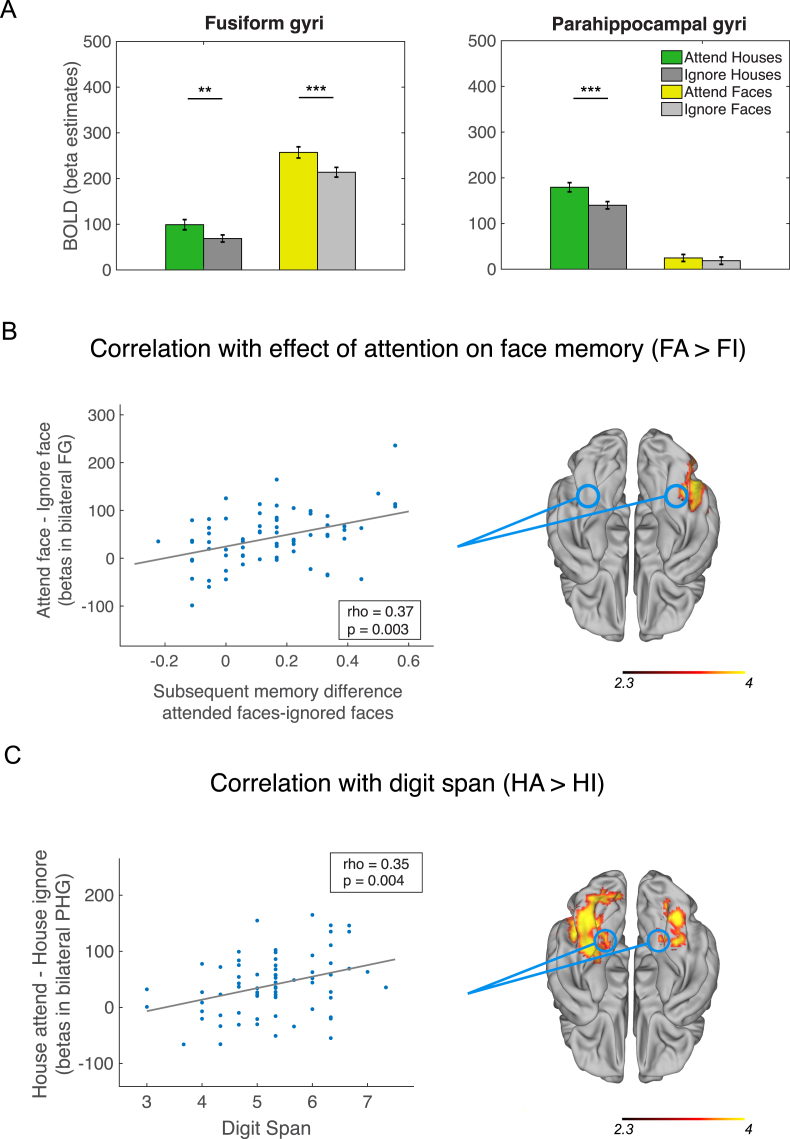
Top-down attentional modulation in category-sensitive visual cortex during selective WM and correlations with behavior. (A) Bar plots showing attention-related modulation of category-sensitive visual cortex (ROI analyses). Left: BOLD activity in bilateral fusiform gyri (FG) was modulated by stimulus category, with greater activity for faces than houses, but attention-related modulation was similar for faces and houses. Bilateral FG showed greater activity in the attend-face (FA; yellow) versus the ignore-face (FI; light grey) conditions, as well as in the attend-house (HA; green) compared to the ignore-house (HI; grey) conditions. Right: BOLD activity in bilateral parahippocampal gyri (PHG) was modulated by stimulus category, with greater activity for houses than faces, and displayed strongly selective attention-related modulation for WM encoding of houses. Bilateral PHG showed greater activity in the attend-house (HA; green) compared to the ignore-house (HI; grey) conditions, but not for attend-face (FA; yellow) versus the ignore-face (FI; light grey) conditions. ***p < 7.89e-08; **p = 0.0003. Beta estimates are in arbitrary units. Error bars represent standard error of the mean. (B–C) The degree of attention-related modulation was positively correlated with the effect of attention on subsequent memory and with digit span. B) Left: Scatterplot of BOLD activity (FA-FI) from participant-defined bilateral FG plotted as a function of subsequent memory difference scores for faces. Right: Degree of attention-related modulation in right lateral occipital cortex (LOC) and FG (approximate locations circled) during selective WM for faces was positively correlated with the effect of attention on subsequent memory for faces. Significant regions are displayed in red-yellow shading (p = 0.001, cluster-corrected). C) Left: Scatterplot of BOLD activity (HA-HI) from participant-defined bilateral PHG plotted as a function of digit span. Right: Degree of attention-related modulation in bilateral IT, including PHG (approximate locations circled) and left LOC during selective WM for houses was positively correlated with digit span, a measure of WM capacity obtained in a separate session. Significant regions are displayed in red-yellow shading (p's < 0.026, cluster-corrected). Activations on brains are z-statistic images. Brains are displayed in neurological convention; L = L.